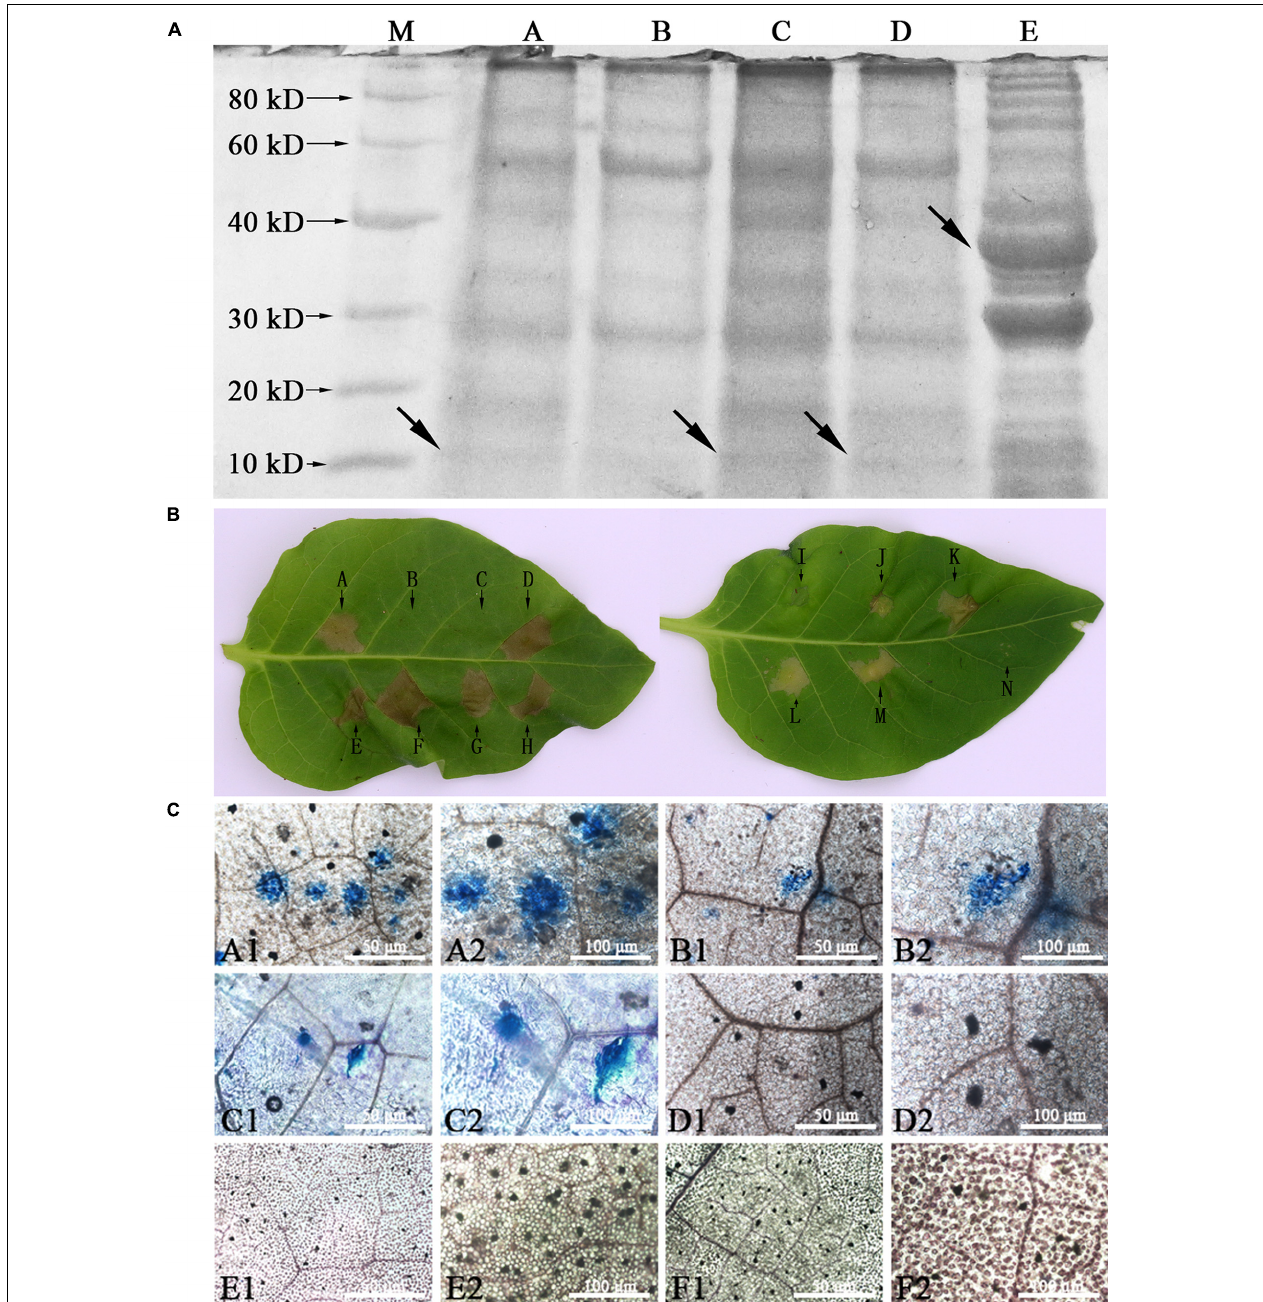
FIGURE 6 | Analysis of soluble proteins from WY195- hpaXm transgenic tobacco. (A) Sodium dodecyl sulfate-polyacrylamide gel electrophoresis (PAGE) patterns of soluble protein preparations. (A) Soluble protein preparations (1 µ L; 308 ng) including hpaXm from induced T1 generation WY195- hpaXm transgenic tobacco. (B) Soluble protein preparations (1 µ L; 361 ng) from N. tabacum wild type; (C) Soluble protein preparations (1 µ L; 366.5 ng) from pBI121- hpaXm transgenic plant; (D) Soluble protein preparations (1 µ L; 301 ng) including hpaXm from uninduced T1 generation WY195- hpaXm transgenic tobacco. (E) Soluble protein preparations (1 µ L; 325 ng) including hpaXm associated with a GST mark. The arrows represent the harpins HpaXm and GST-HpaXm (E). (B) Soluble proteins of hpaXm from WY195- hpaXm transgenic tobacco could stimulate HR. Bioactivity assays of proteins from leaf tissues, compared with the preparations of GST-hpaXm from E. coli . (A) GST-hpaXm (325 ng/ µ L) (CK + ); (B) N. tabacum wild type (CK − ) (361 ng/ µ L); (C) pBI121 transgenic tobacco (344 ng/ µ L); (D), (E), and (F) induced T1 generation WY195- hpaX m tobacco (308 ng/ µ L); (G) and (H) pBI121- hpaXm transgenic tobacco (366.5 ng/ µ L) (CK + ); (I) PBS buffer (1 µ L); (J), (K), (L) and (M) uninduced WY195- hpaXm transgenic tobacco (288 ng/ µ L); (N) ddH 2 O (CK - ). (C) Trypan blue staining of WY195- hpaXm transgenic tobacco leaves. Micro-HRs were shown as areas stained blue. (A1) and (A2) induced WY195- hpaXm transgenic N. tabacum ; (B1) and (B2) pBI121- hpaXm transgenic N. tabacum ; (CK + ); (C1) and (C2) with exogenous application of the hpaXm proteins (CK + ); (D1) and (D2) pBI121 transgenic N. tabacum (CK − ); (E1) and (E2) uninduced WY195- hpaXm transgenic N. tabacum ; (F1) and (F2) N. tabacum wild type (CK − ).